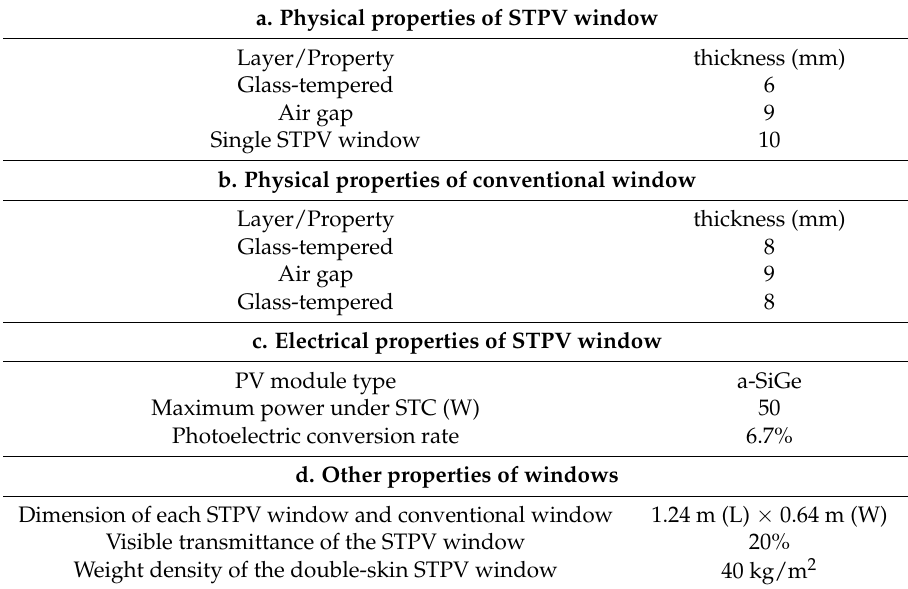
Table 1. Physical and electrical properties of STPV window and conventional